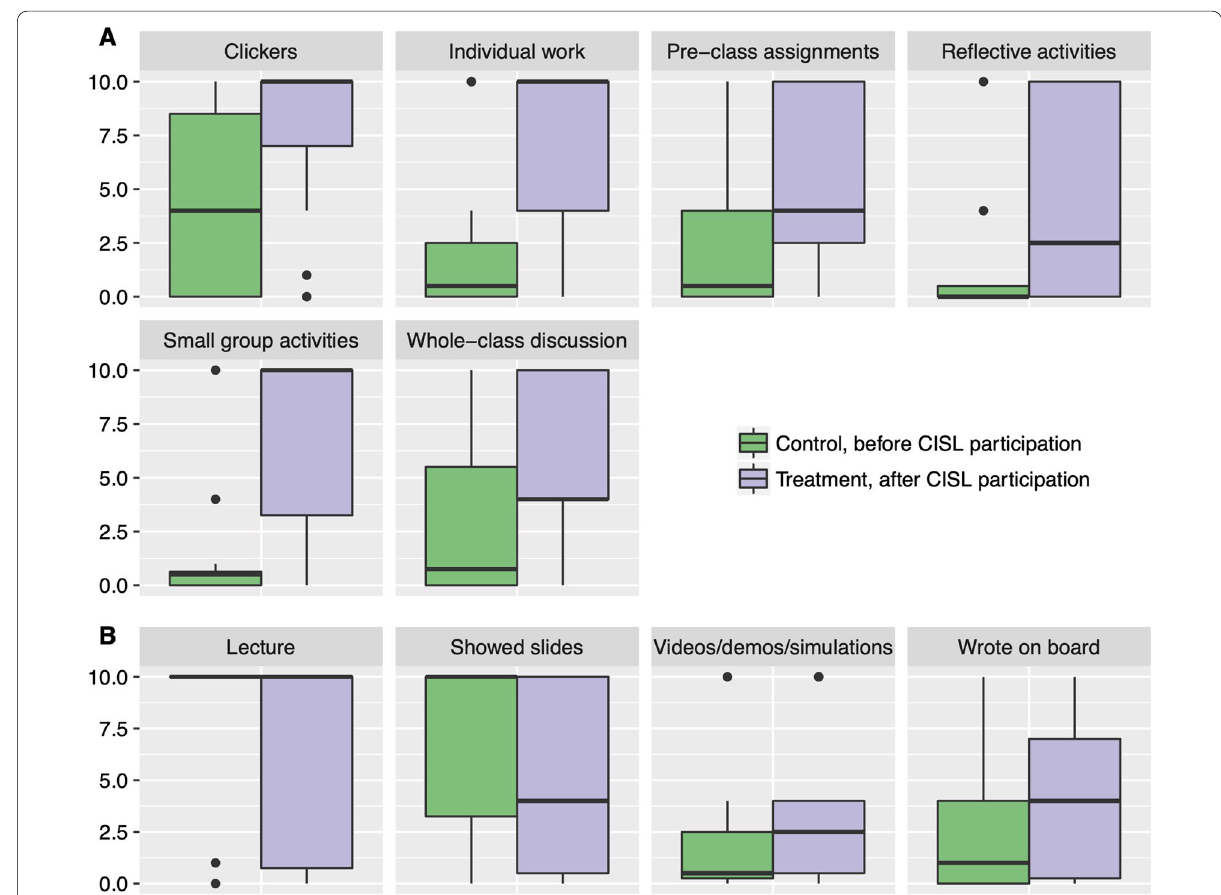
Fig. 2 Frequency of use of instructional practices by Faculty Scholars before and after CISL program participation. This figure shows frequency of use of student-centered ( A ) and instructor-centered ( B ) instructional practices for a sample of Faculty Scholars, before or after participation in the CISL program. The faculty reported their frequency of use of instructional practices in the STEM course they most frequently teach either in the most recent occasion they taught the course (i.e., treatment, after CISL participation, in purple) or in the oldest occasion in the last 5 years (i.e., control, before CISL participation, in green). The boxplots show the distribution of responses, with the median indicated by the middle horizontal line, the box representing the middle 50% of scores for the population, and the upper and lower whiskers indicating the range of the upper and lower quartile, respectively. Please note that items with highly skewed responses (e.g., Lecture, control) will have compressed boxplots. The y -axis is a linearized scale of the frequency of use of instructional practices in a term, using the monthly frequency as the unit with 0 times per term”, 1 “Monthly”, 4 “Weekly”, and 10 “Every = = =